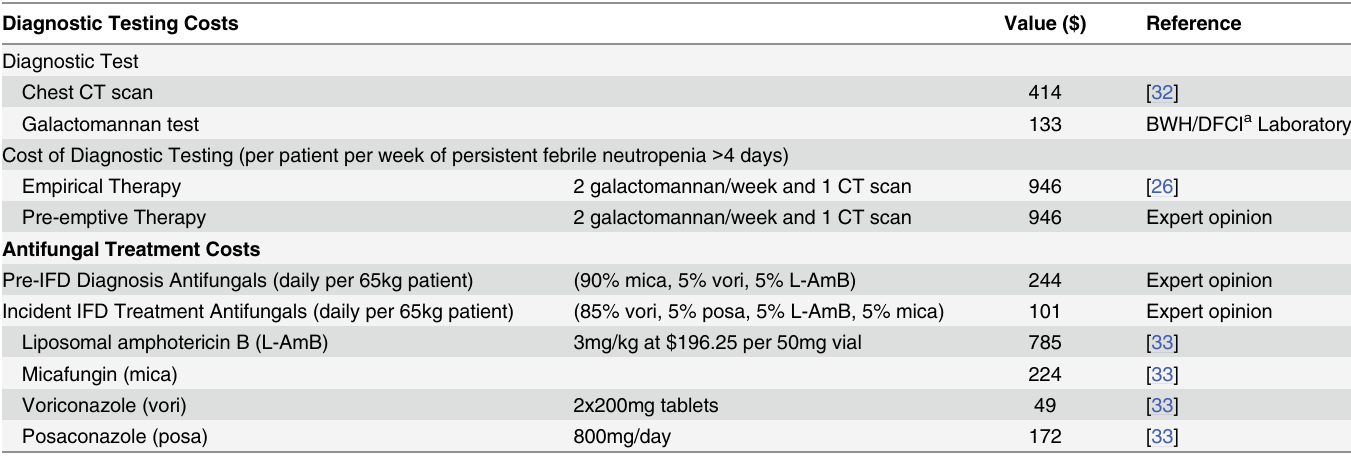
Table 5. Cost parameters incorporated into cost comparison model.